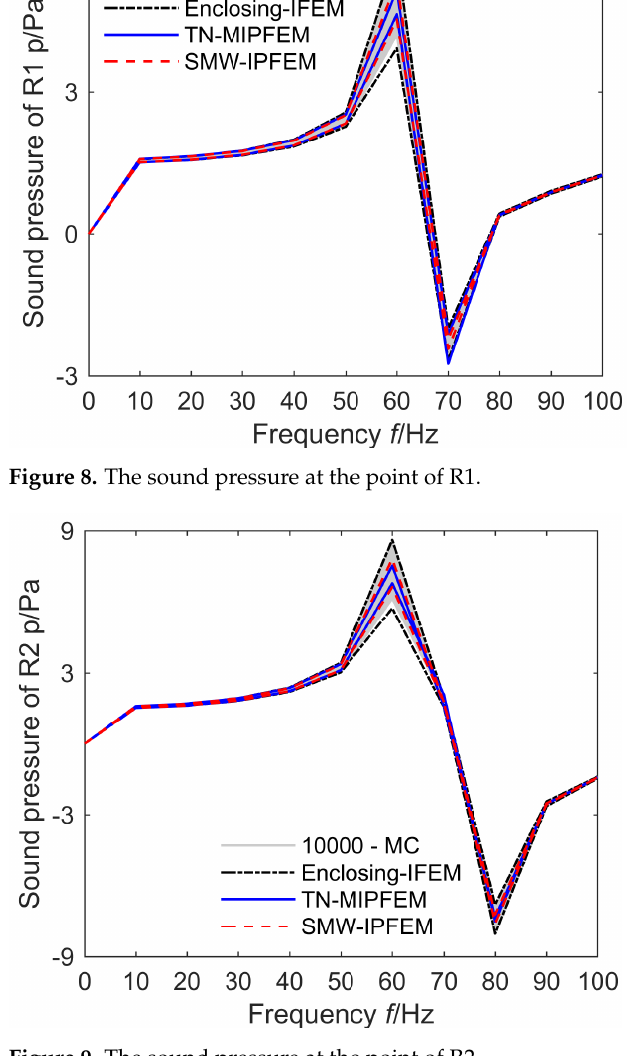
Figure 9. The sound pressure at the point of R2.